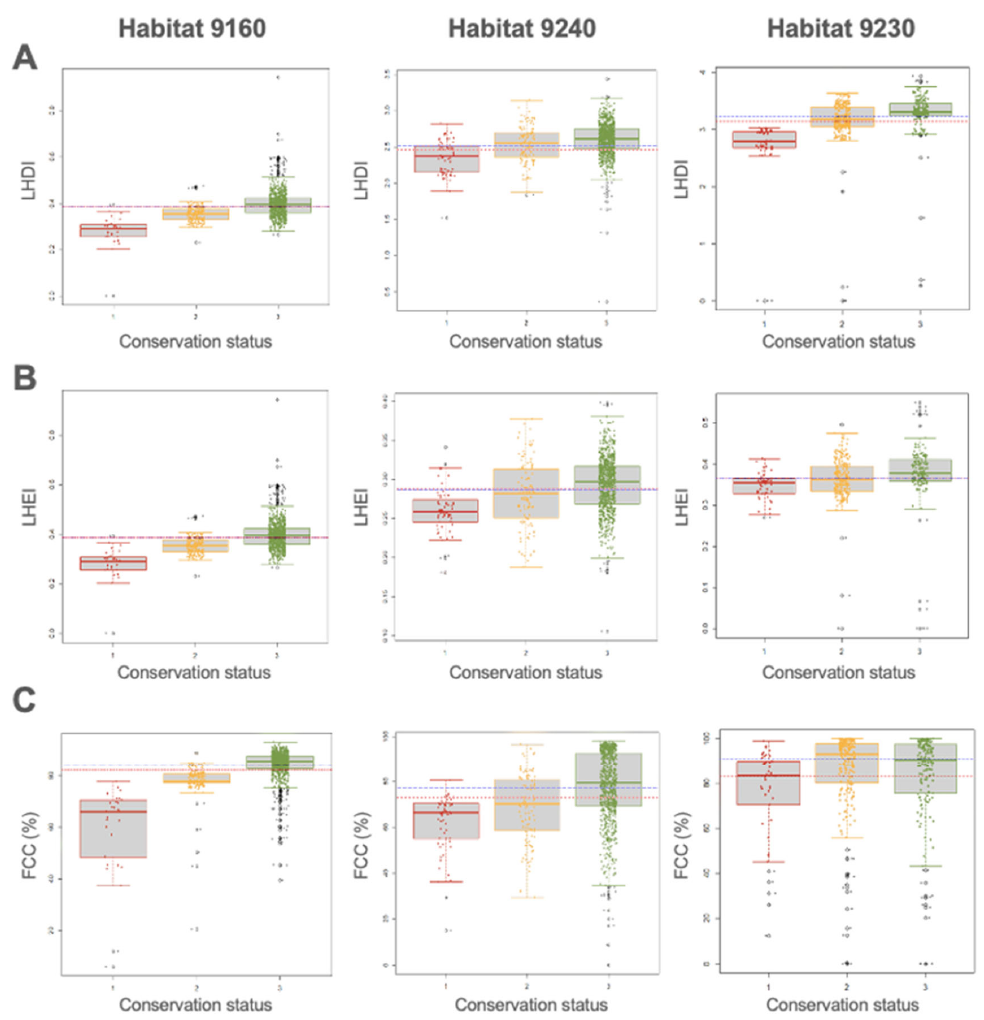
Figure 3. Box plot diagrams of the significant variables ( A ) LHDI, ( B ) LHEI, and ( C ) FCC (%) between conservation status for habitats 9160, 9240, and 9230. The dashed blue line denotes the median, and the dotted red line is the average mean. 1: unfavorable-bad status (red); 2: unfavorable-inappropriate status (yellow); 3: favorable status (green). Additionally, 9160 is Quercus robur habitat, 9230 is Quercus pyrenaica habitat, and 9240 is Quercus faginea habitat .